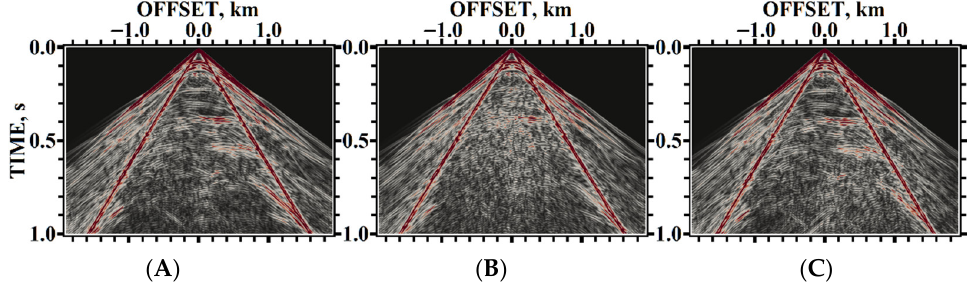
Figure 36. Example #5, seismograms, velocity modulus: ( A ) «without fractures»; ( B ) «fractured zone #1»; ( C ) «fractured zone #2».